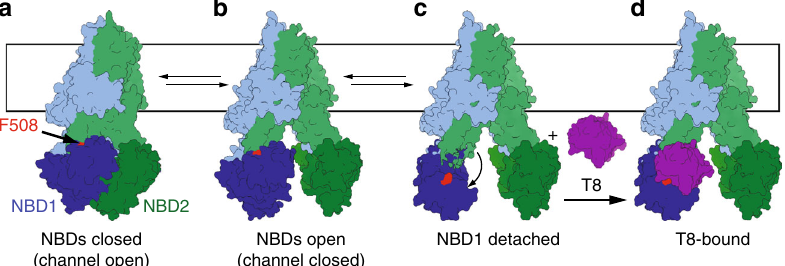
Fig. 7 NBD1 must undock from the TMDs to allow binding of nanobodies T4 or T8. Current models indicate that CFTR alternates between a state where the two NBDs are in close contact (state a ), leading to channel opening, and a state where the NBDs separate leading to channel closing (state b ). State a would typically be induced by PKA phosphorylation. States a and b have been observed by cryo-EM and both bury F508 in the NBD1-TMD interface. Nanobodies T4 and T8 bind an epitope containing F508 (illustrated in red), thus requiring a transient undocking of NBD1 from the TMDs (state c ). This transient state can be stabilized upon binding of these nanobodies (state d